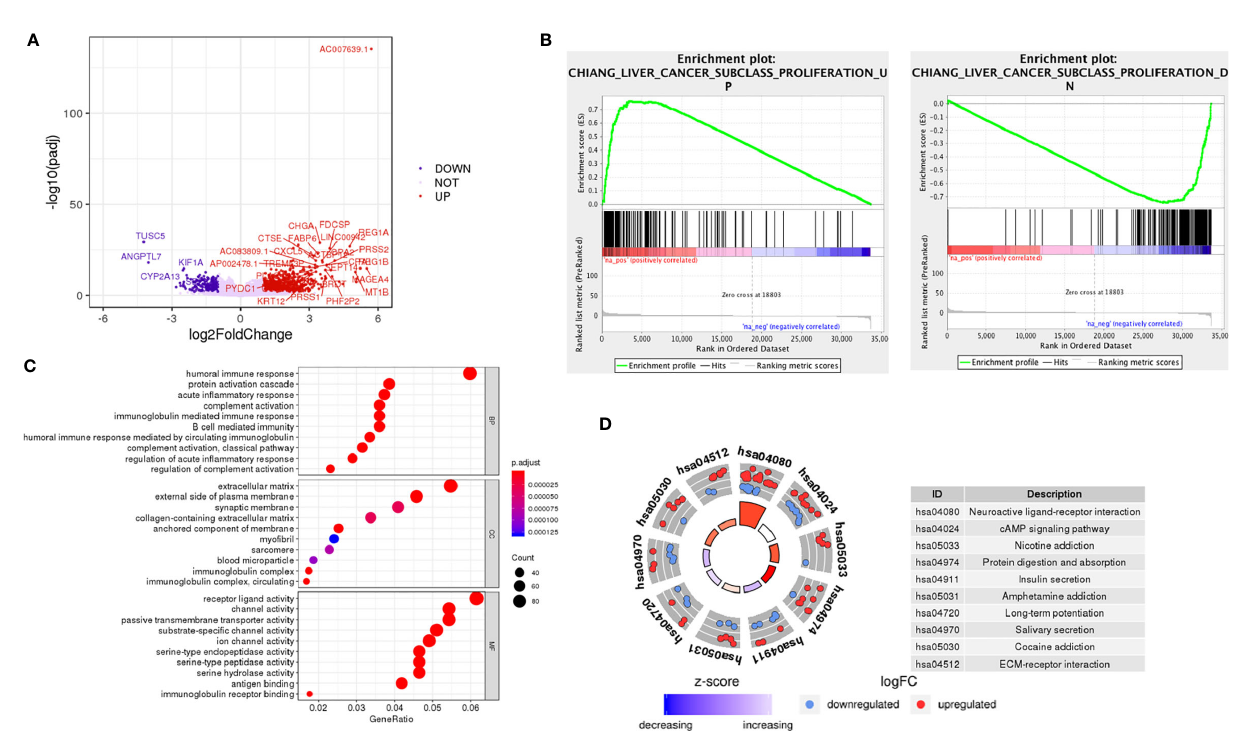
FIGURE 2 | The role of LncRNA AC007639.1 in liver cancer. (A) Differential gene expressions between the high- and low- expression of lncRNA AC007639.1 groups (TCGA-LIHC). (B) LncRNA AC007639.1 functions analyzed by GSVA. The up-regulated genes in proliferative liver cancer were highly enriched in the AC007639.1 high expression group (p<0.001), while the down-regulated genes in proliferative liver cancer is highly enriched in the AC007639.1 low expression group (p<0.001). (C) GO analysis and (D) KEGG and cluster network analysis using Clusterpro fi ler Package of R language, screening criteria p < 0.05, correction p < 0.05.